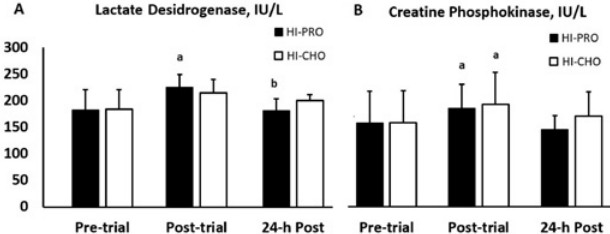
Figure 2. Serum Lactate Desidrogenase (A) and Creatine Phosphokinase (B) at pre-, post- and 24h-post-trial in high protein (HI-PRO) and high carbohydrate (HI-CHO) conditions. ap≤0.026 for this moment measurement vs. the others, bp=0.019 vs. HI-CHO